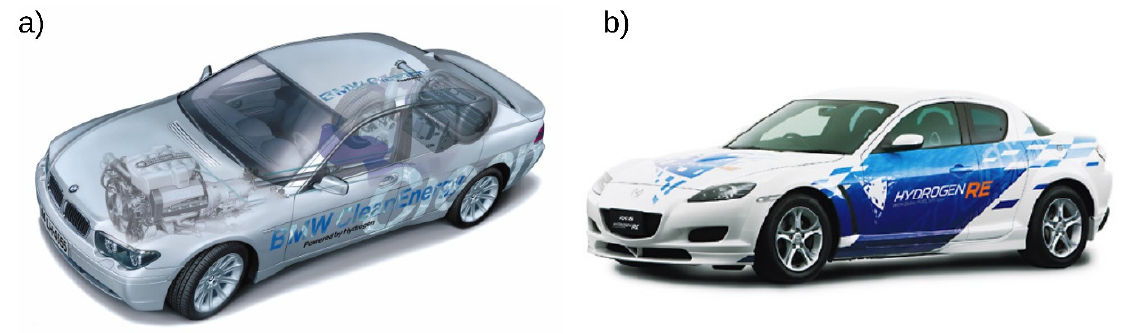
Figure 1. BMW Hydrogen 7 [57] ( a ) and Mazda RX-8 Hydrogen RE [9] ( b ).